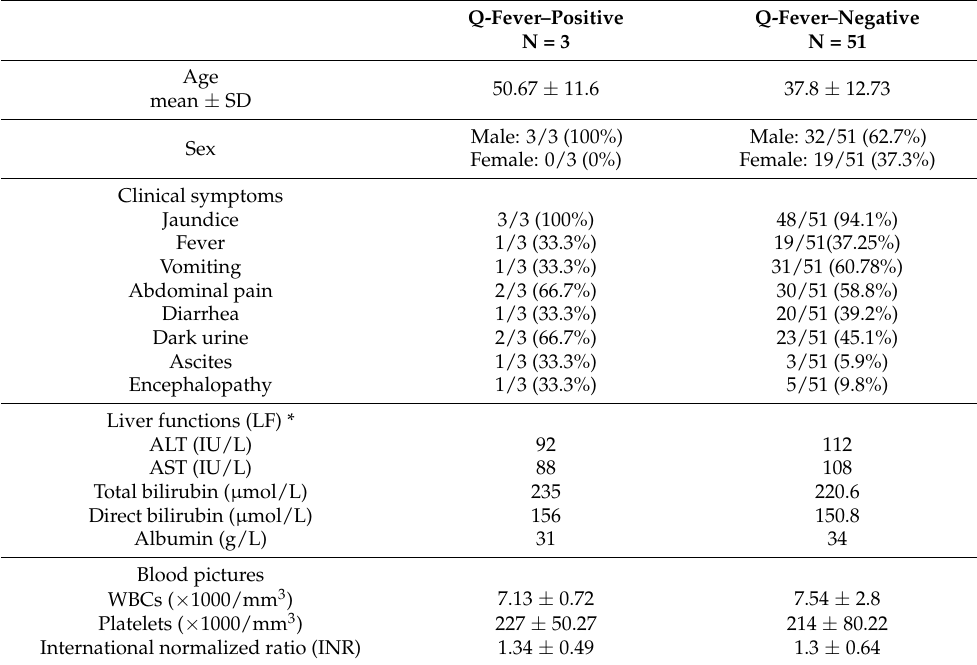
Table 3. Comparison between Q-fever-positive and Q-fever-negative AHUE patients.